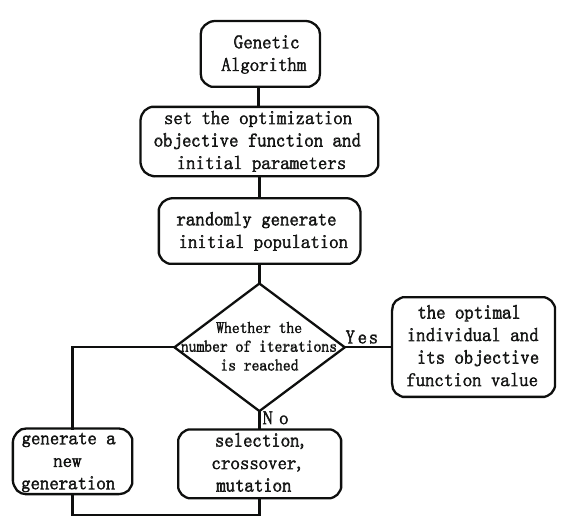
Figure 3. Genetic Algorithm Flowchart.